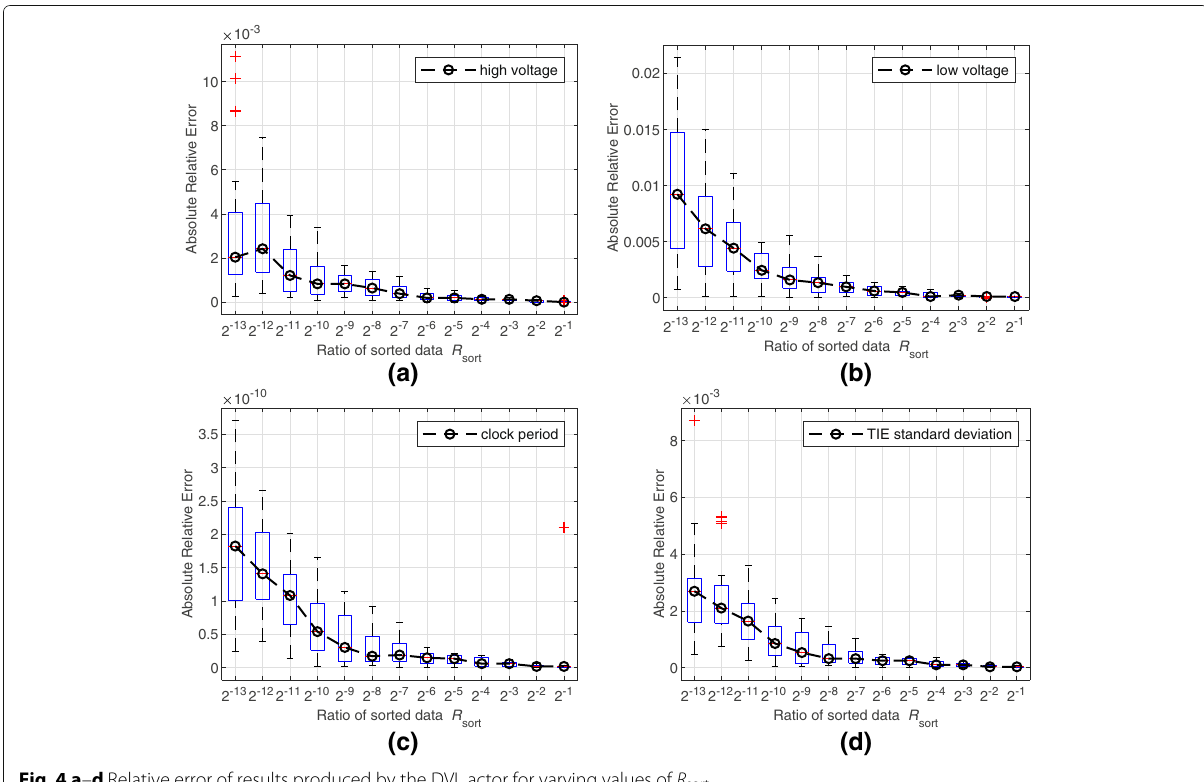
Fig. 4 a – d Relative error of results produced by the DVL actor for varying values of R sort achieved with relatively low reduction in accuracy— although the magnitudes of throughput speedups are somewhat lower. Also, the throughput speedup is not linear. We expect that this is due to nonlinear effects related to memory cache operations and work group size organization in OpenCL.